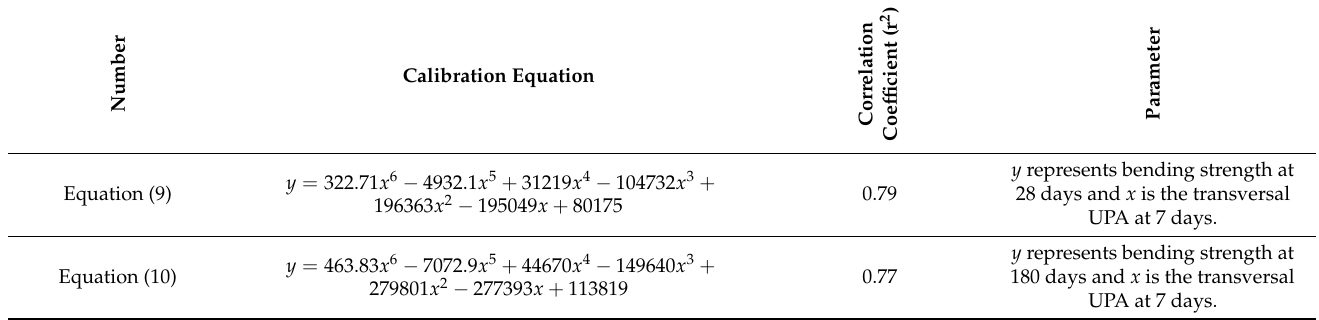
Table 7. Calibration equations for predicting bending strength from transversal UPA.